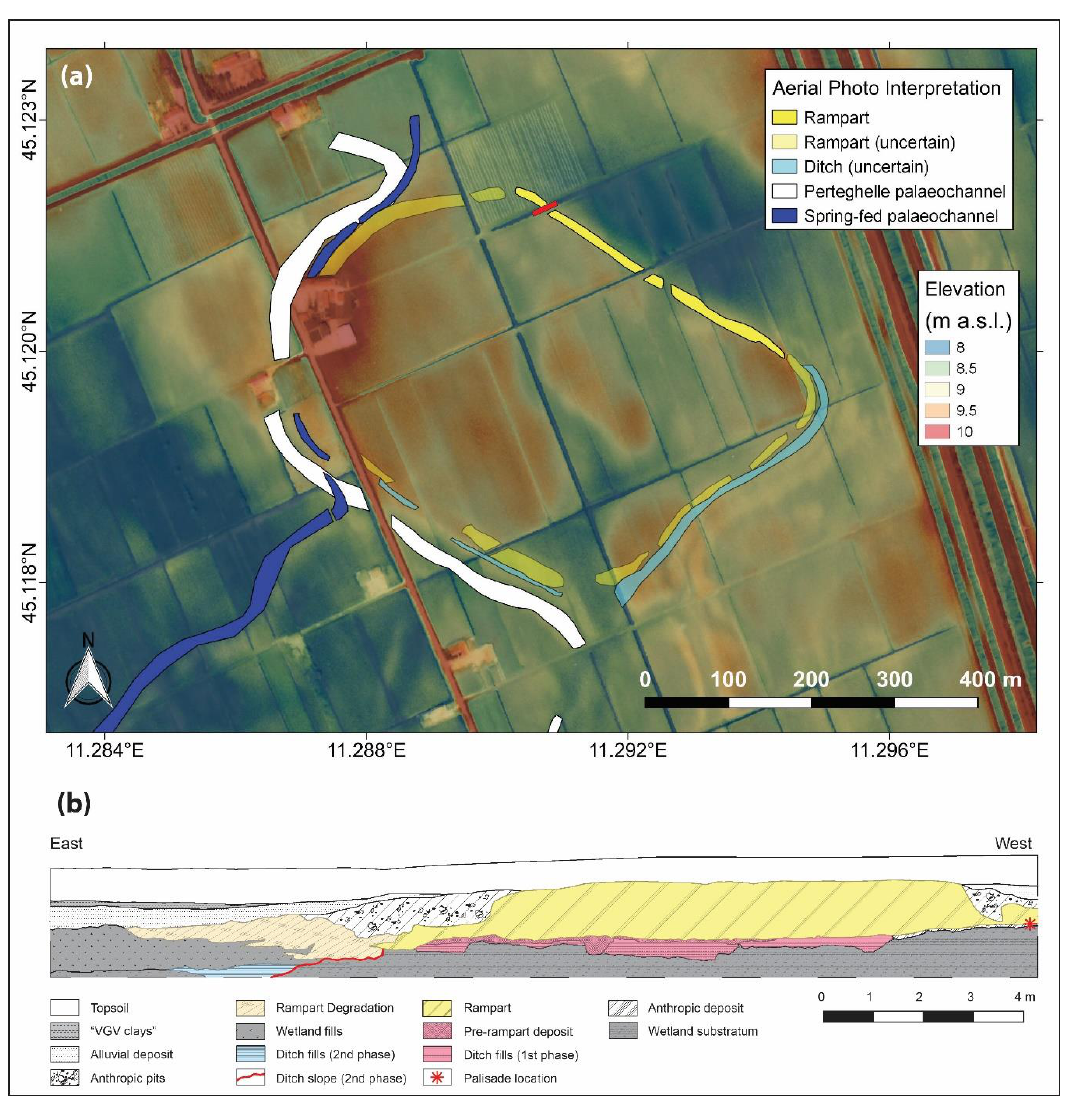
Figure 6. ( a ) Reconstruction of the fortified Fondo Paviani settlements with probable recent Bronze Age hydrographic network identified from aerial photo-interpretation (orange line: stratigraphic section segment intercepting the perimeter structures (overlapping of DTM obtained from LIDAR with 1990 C.G.R aerial frame). ( b ) The segment of the stratigraphic section intercepting the perimeter structures.